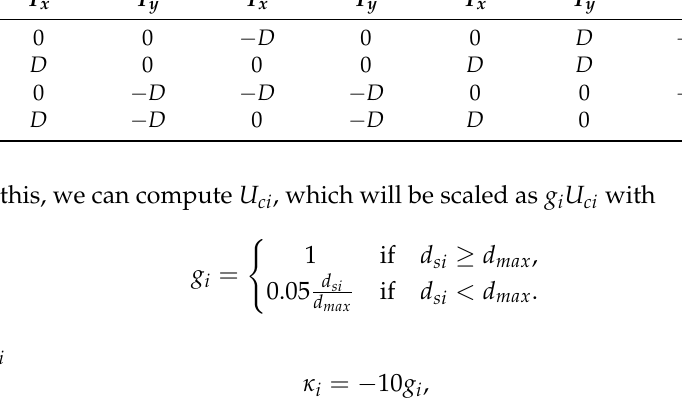
Table 1. Final formation distance between robots in the 4-robot experiment.